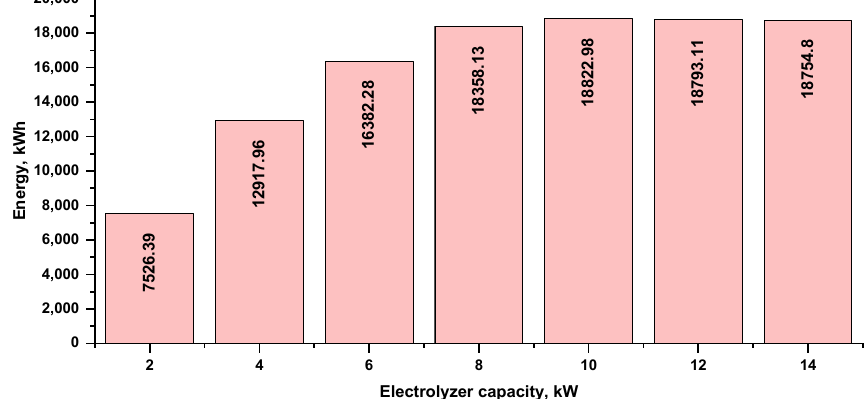
Figure 9. Annual energy consumption by the electrolyzer at various capacities.